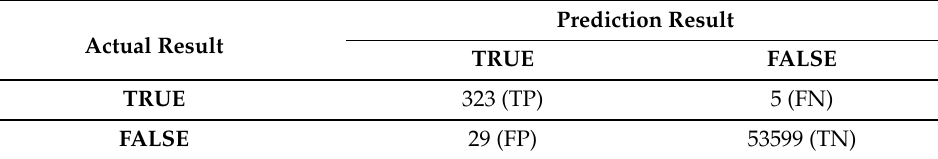
Figure 6. Overhead Proportion of Each Step in Facial Recognition. Table 7. Test Results of Facial Recognition and Comparison.